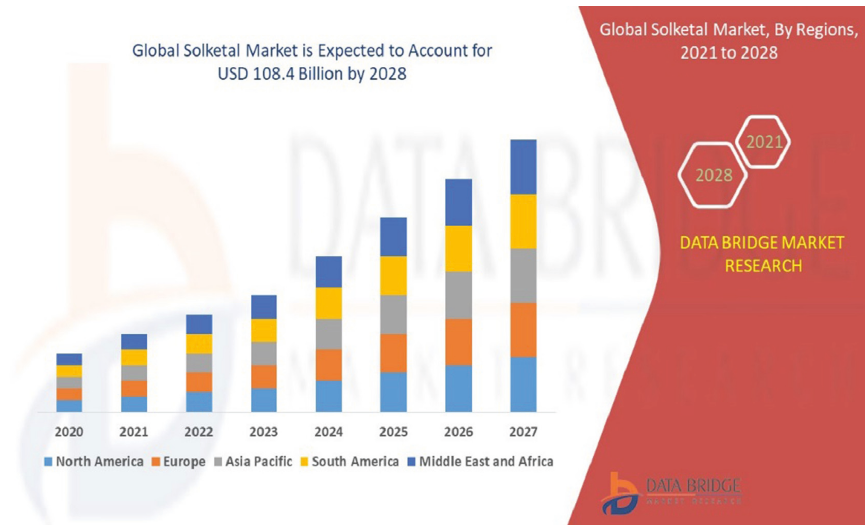
Figure 1: Global industry trends and forecast to 2028